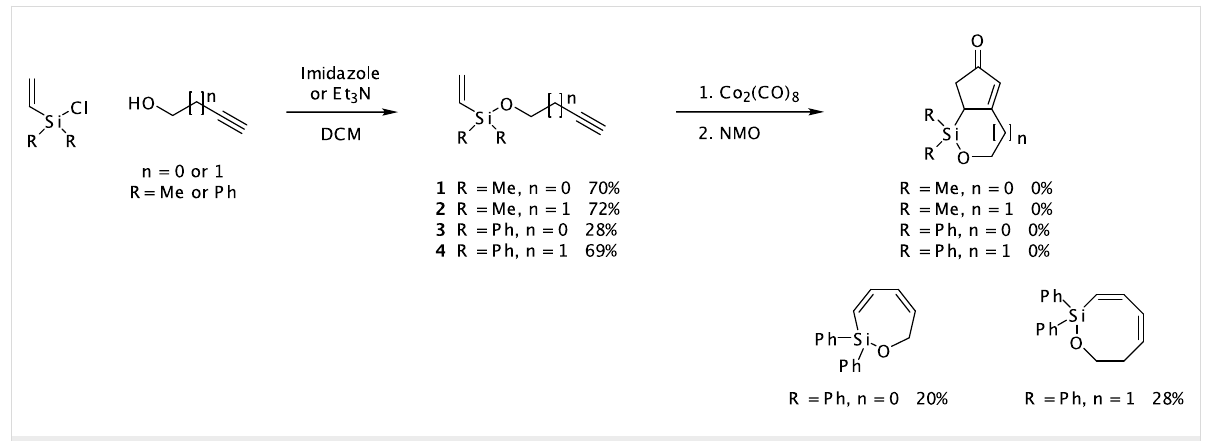
Scheme 5: Synthesis and attempted Pauson-Khand reactions of vinyldimethylsilyl- and vinyldiphenylsilyl ethers.